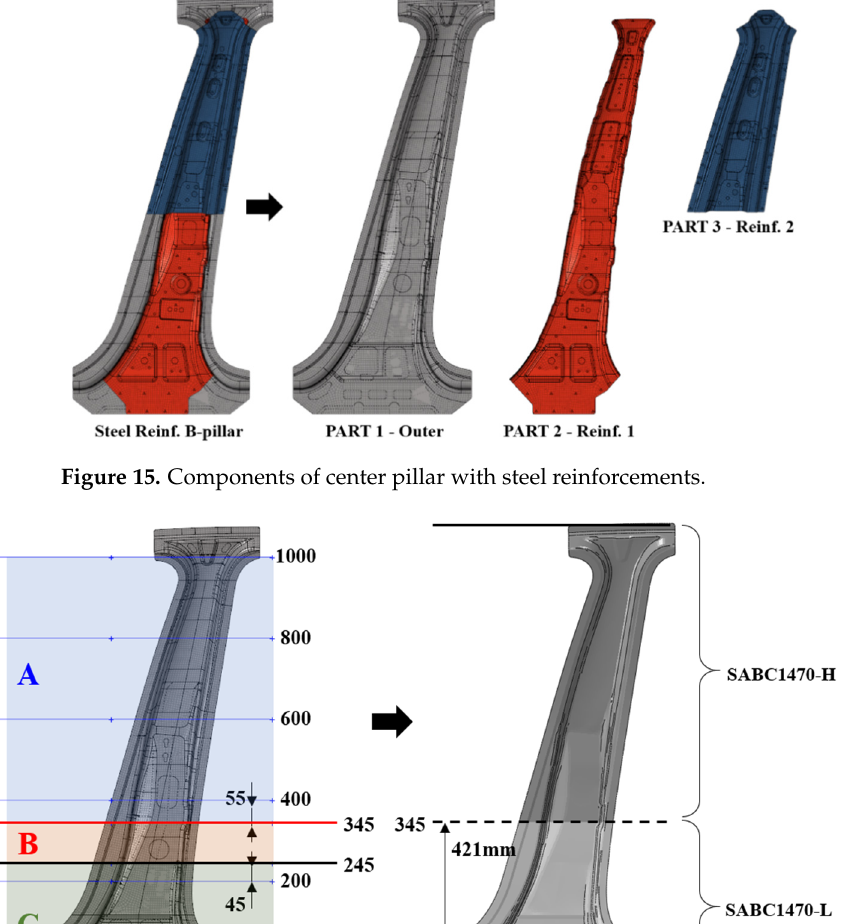
Figure 16. Material properties and application information of hot-stamped steel outer part. Table 4. Mechanical properties of center pillar with steel reinforcements [22–24].